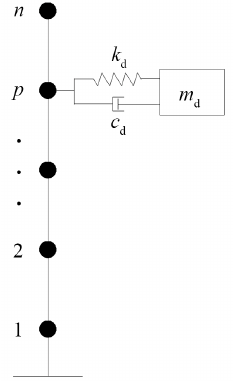
Figure 21. A multi-degree-of-freedom model with an ECTMD.